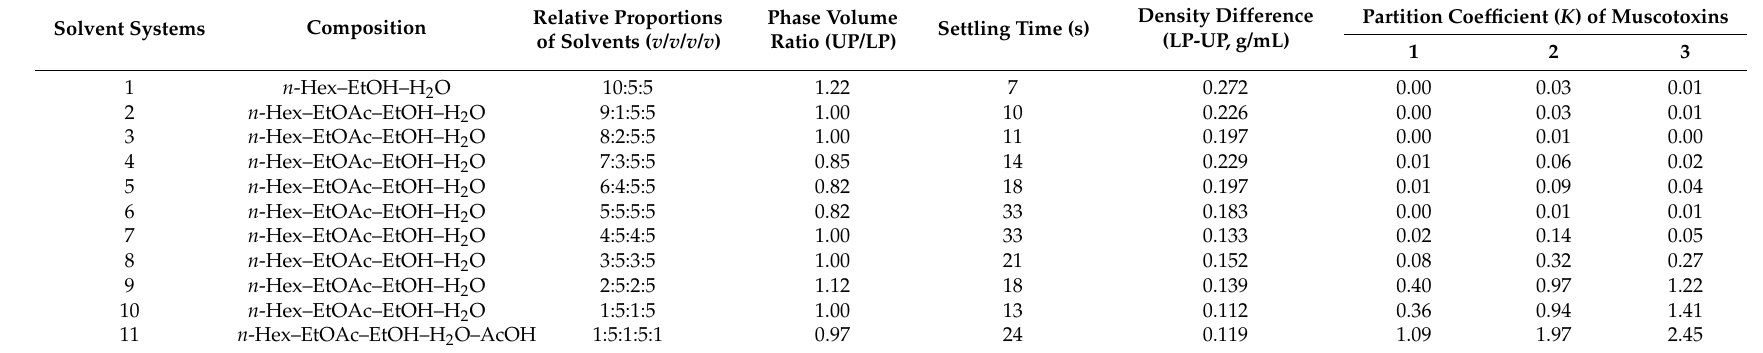
Table 1. The partition coefficient ( K ) and separation factor ( α ) values of three muscotoxins from D. muscorum CCALA 125 in different two-phase solvent systems and the settling